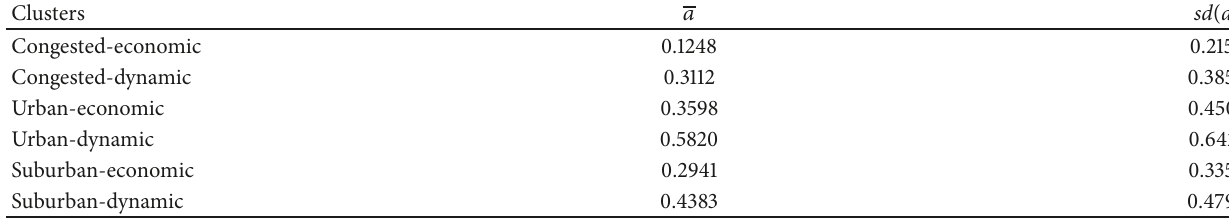
Table 6: Driving style cluster centers in 3 driving cycles.